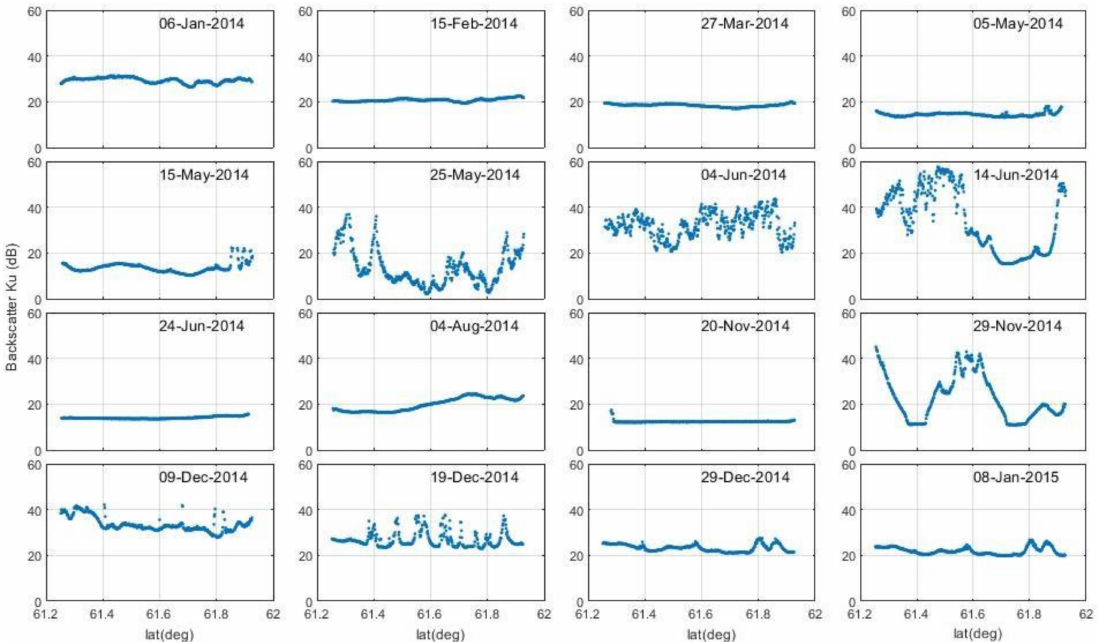
Figure 3. Profiles of backscatter along Jason-2 track 045 over Great Slave Lake from January to December 2014.